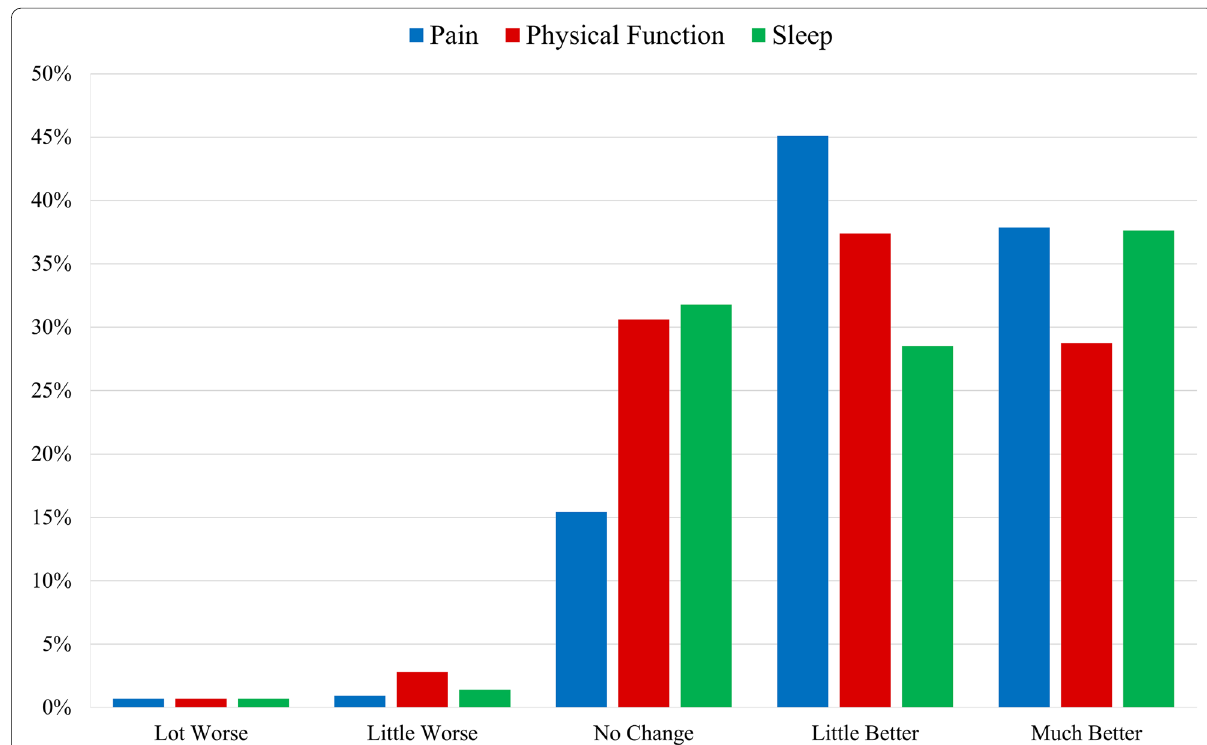
Fig. 1 Patients’ global impression of change of pain intensity, physical function, and sleep after using CBD for their joint pain. *“Much better” response has previously been validated as a clinically meaningful